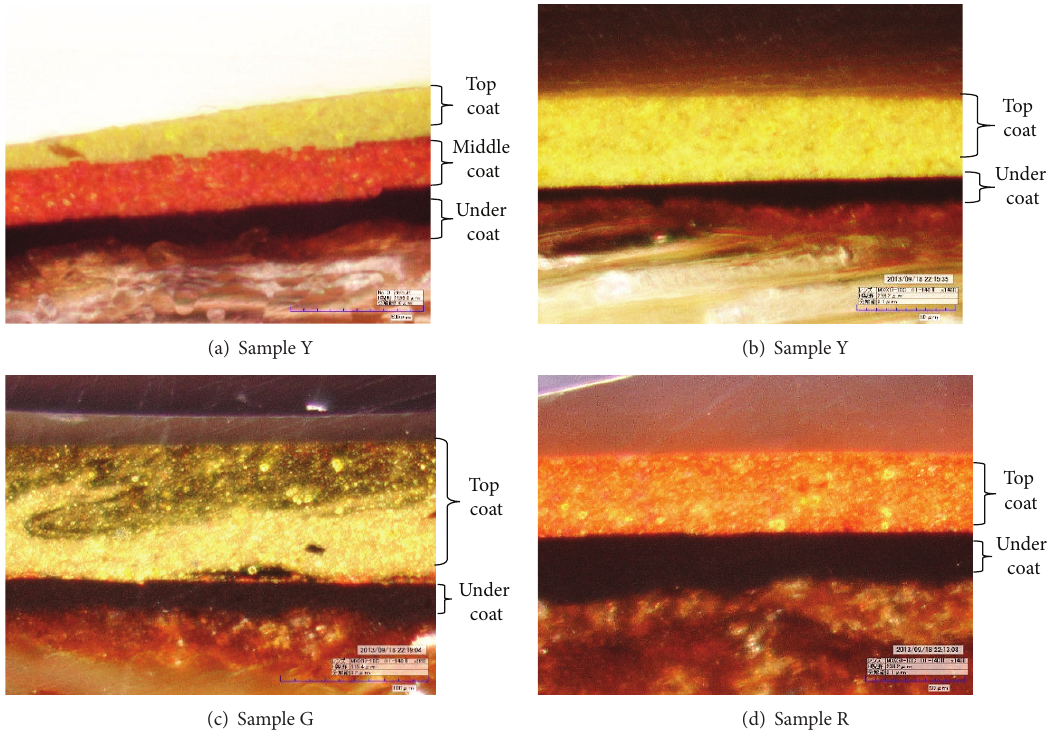
Figure 4: Cross-sectional photos of Sample Y (a) and (b), Sample G (c), and Sample R